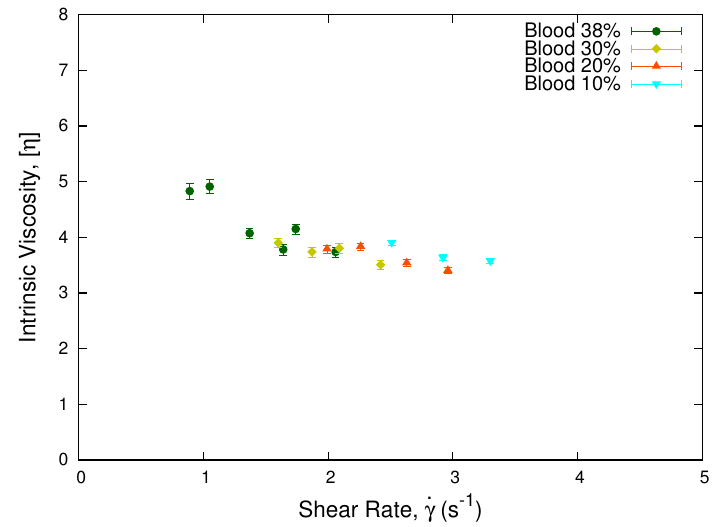
Figure 5. Intrinsic viscosity vs. shear rate. The plot show the collapse of the intrinsic viscosity values for a sample from a single donor separated in different hematocrits. The normalization was performed using the linear approximation of the Krieger and Dougherty model, Equation (17), being consistent with the collapse observed in Figure